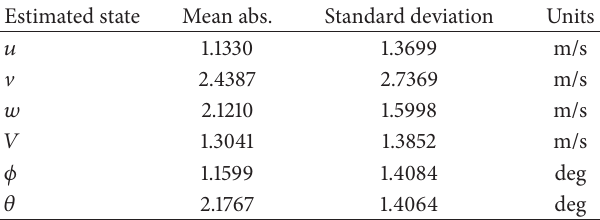
Table6:Flight#1errorstatisticsforestimatedstateswithrangestate. Estimated state